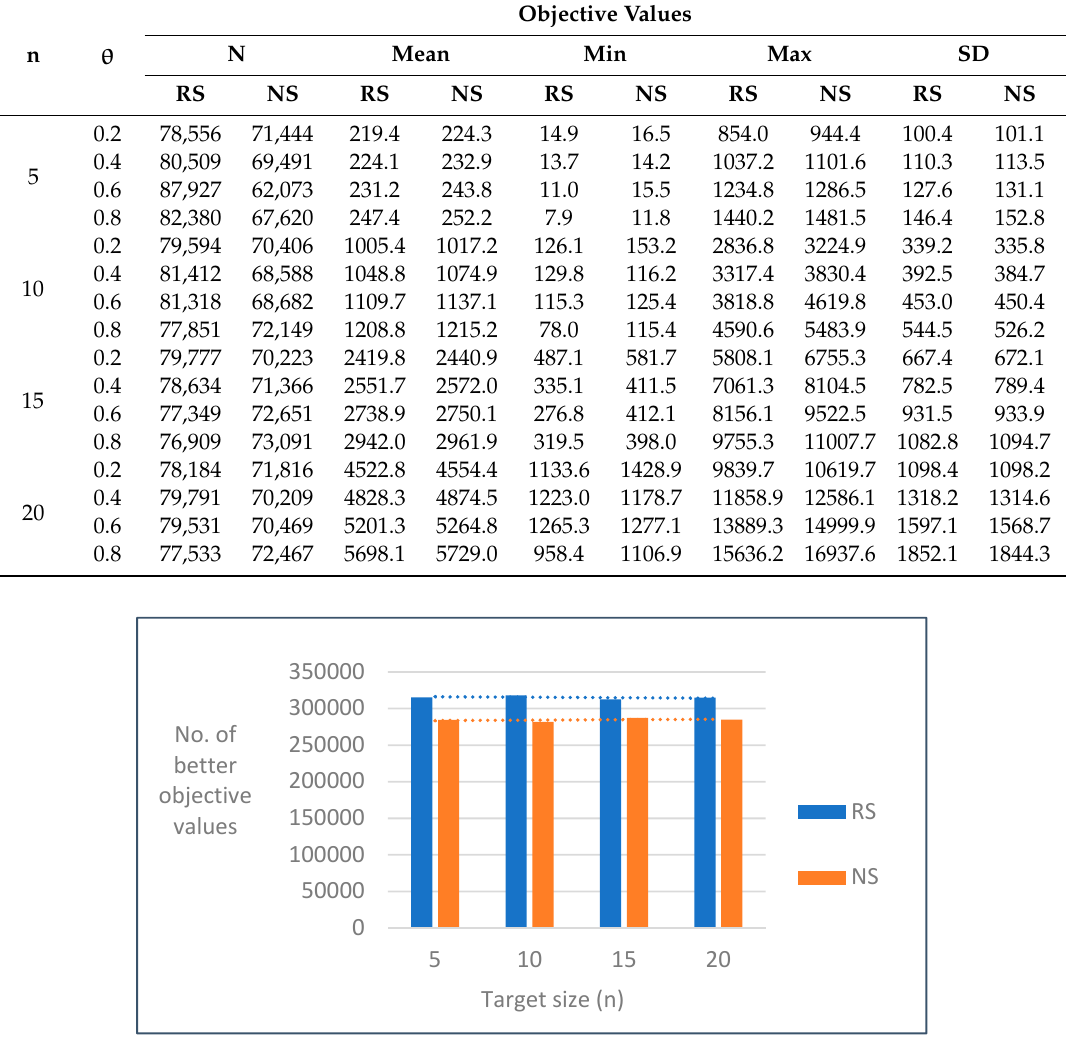
Figure 2. Number of better objective values between robust solution (RS) and nominal solution (NS) among 600,000 simulation results.